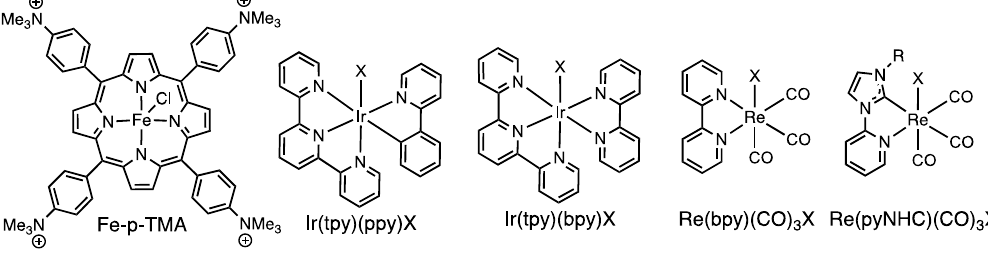
Figure 1. Known photocatalysts for CO 2 reduction.